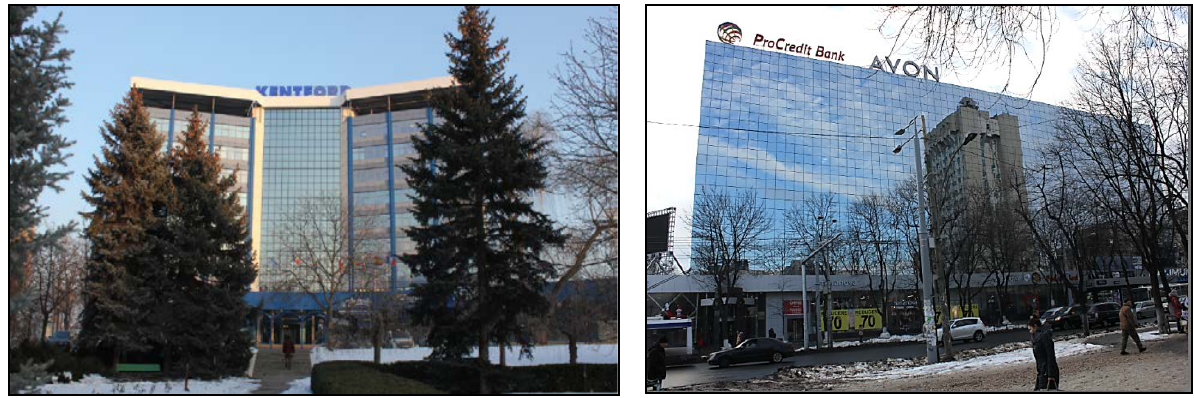
Figure 19. The BC KENTFORD, 1978. Figure 20. The BC JSC